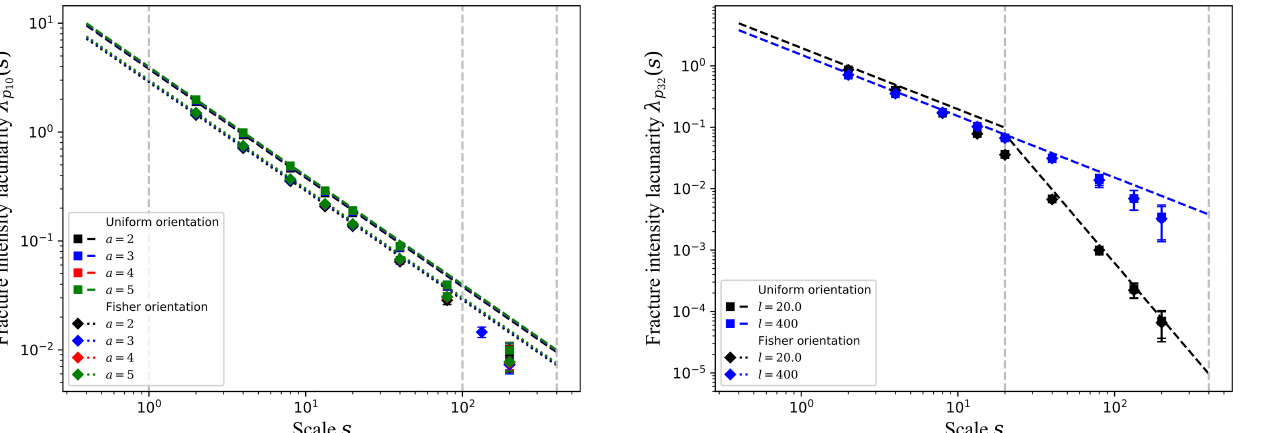
for networks 32